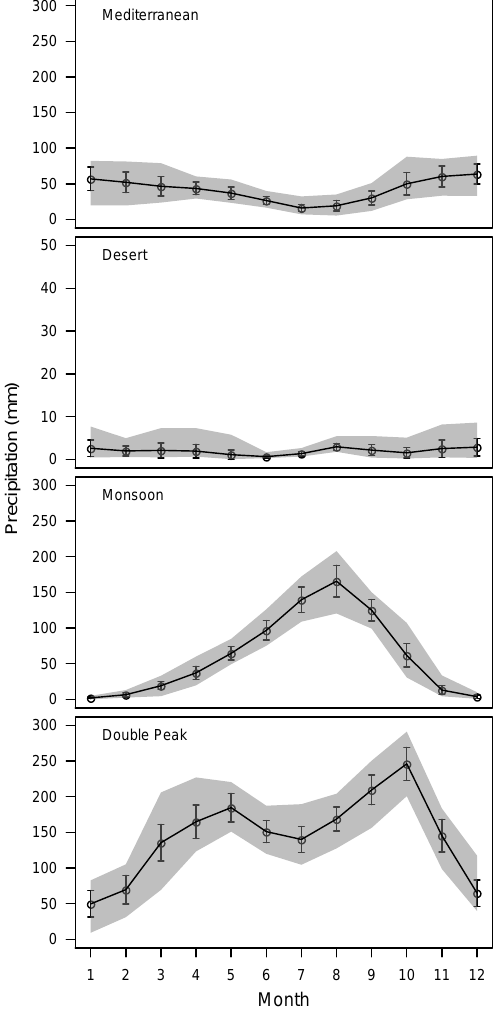
Fig. 1. Observed seasonal cycle of precipitation in each of the de- fined climate zones, using the CRU T3.1 data set (Harris et al., 2014). The mean precipitation each month (mm) is shown by the black line, with the standard deviation shown by the bars. The grey shading shows the maximum and minimum rainfall experienced within the observation period (1961–1990). Note that the scale for the desert region differs from that used for the other regions. Months are numbered consecutively from January (1) through to December